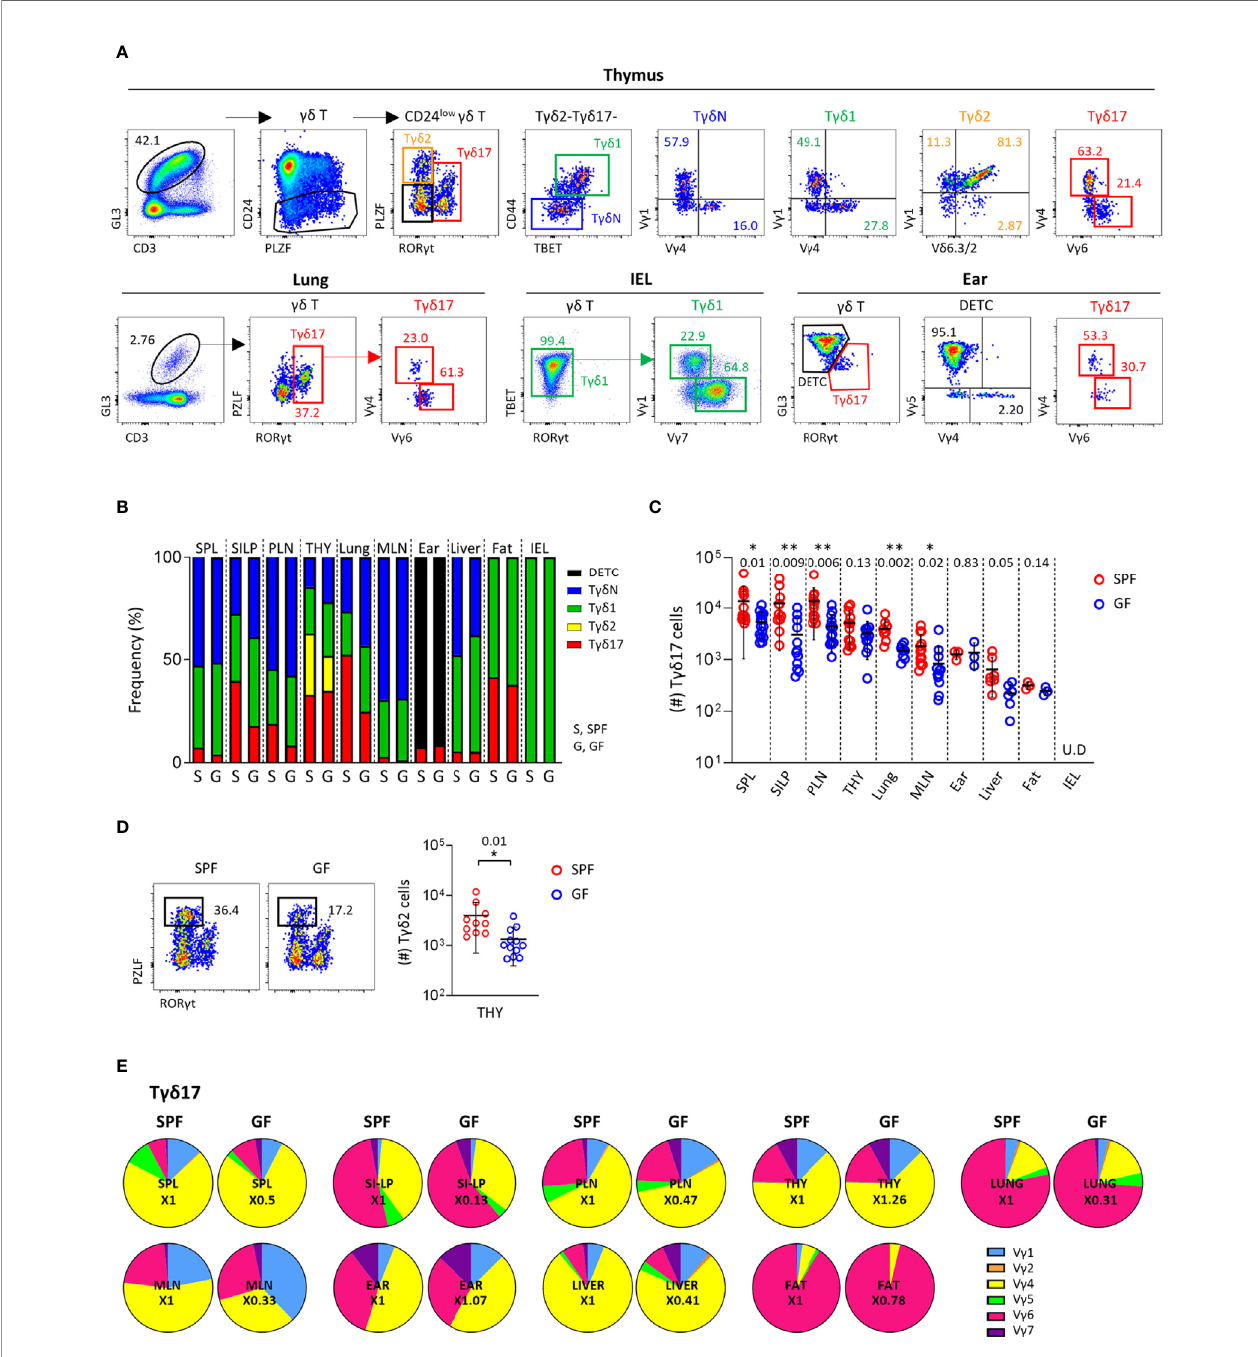
FIGURE 1 | Peripheral homeostasis of T gd 17 cells is dependent on commensal microbiome. (A) FACS gating strategy is shown for analysis of V g TCR repertoire of each subset of gd T cells in thymus, lung, IEL and ear of B6 mice. (B – E) Single cell suspensions of indicated organs from SPF and GF (6-week-old) C57BL/6 (B6) mice were analyzed by fl ow cytometry. Thymus is gated on CD24 low cells. Numbers indicate frequencies of cells in adjacent gates. (B) Bar graphs show mean frequencies of T gd 17, T gd 2, T gd 1, naïve gd T (T gd N), and dendritic epidermal T cells (DETC) cells among total gd T cells and CD24 low cells (thymus). (C, D) Graphs show statistical analysis of absolute numbers of T gd 17 cells in indicated tissues (C) and T gd 2 cells in the thymus (D) . Numbers indicate P values. Representative dot plots show T gd 2 cells in the thymus. (E) Pie charts show mean frequencies of each V g TCRs among total T gd 17 cells. Numbers indicate fold changes. Pooled data from at least three independent experiments are shown (N = 3 ~ 14). Each dot represents an individual mouse and horizontal bars show mean values. Data are presented as mean ± SD. U.D, undetected. Unpaired two-tailed t -test was used. *P < 0.05, **P < 0.01. SPF, speci fi c pathogen free; GF, germ-free; SPL, Spleen; SI-LP, small intestinal lamina propria; PLN, peripheral lymph node; THY, thymus; MLN, mesenteric lymph node; IEL, intraepithelial